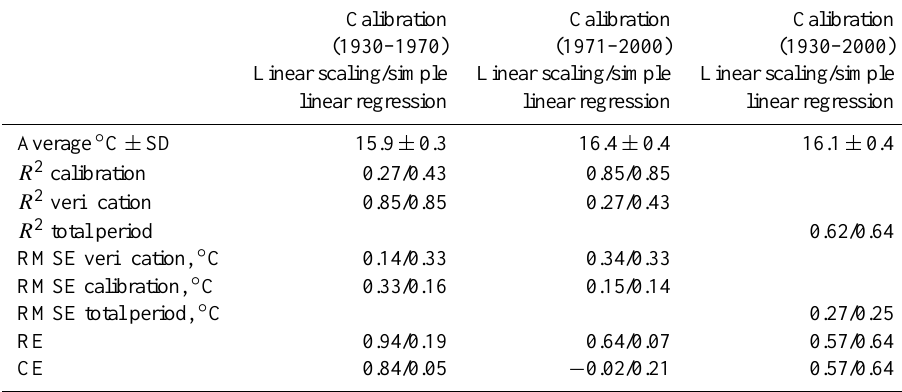
Table 1. Summary of the verification statistics for calibrations using the linear scaling and simple linear regression methods for different periods, and using the measured maximal temperature